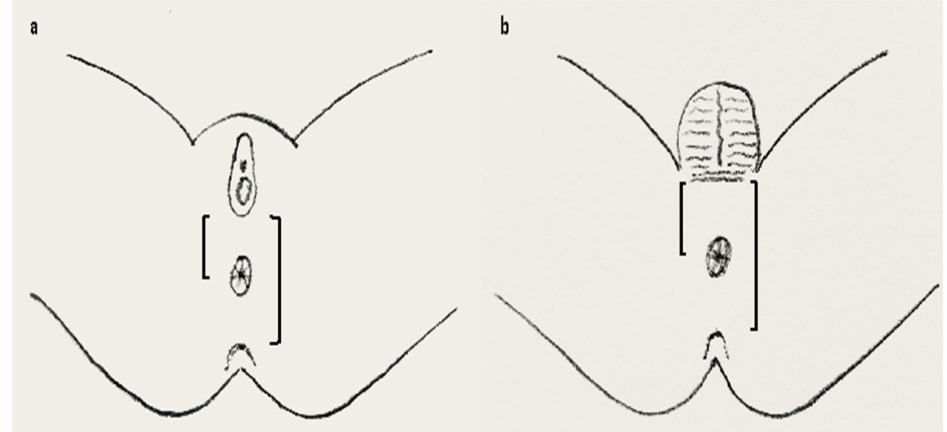
Figure 3. API measurement in females ( a ) and males ( b ). API is calculated by dividing the distance between the fourchette ( a ) or scroto-perineal fold ( b ) to the center of the anus with the distance between fourchette ( a ) or scroto-perineal fold ( b ) to the tip of the coccyx marked on a transpar- ent tape or flexible ruler. Anterior displacement is diagnosed when the API is <0.34 in females and <0.43 in boys (overall mean minus 2 standard deviations as presented by Sharma et al. [40]). API = anal position